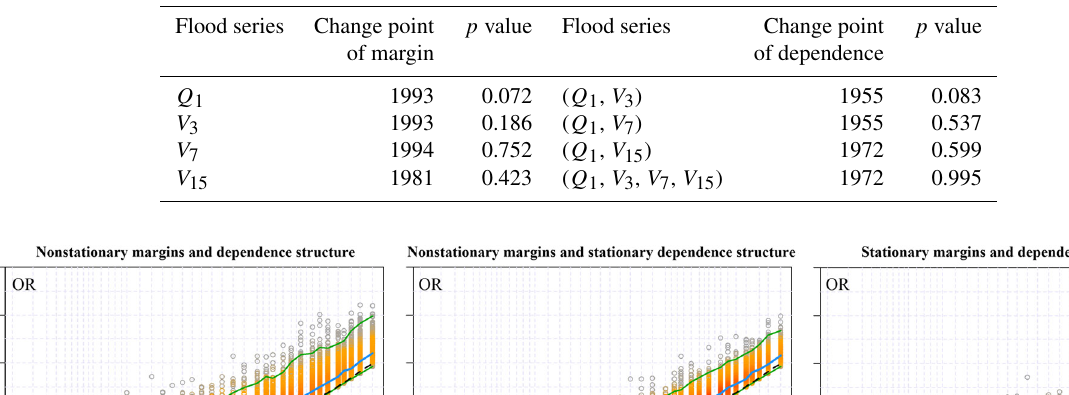
Table 4. Results of change-point detection for the marginal distributions and dependence of (Q 1 , V 3 , V 7 , V 15 ) .